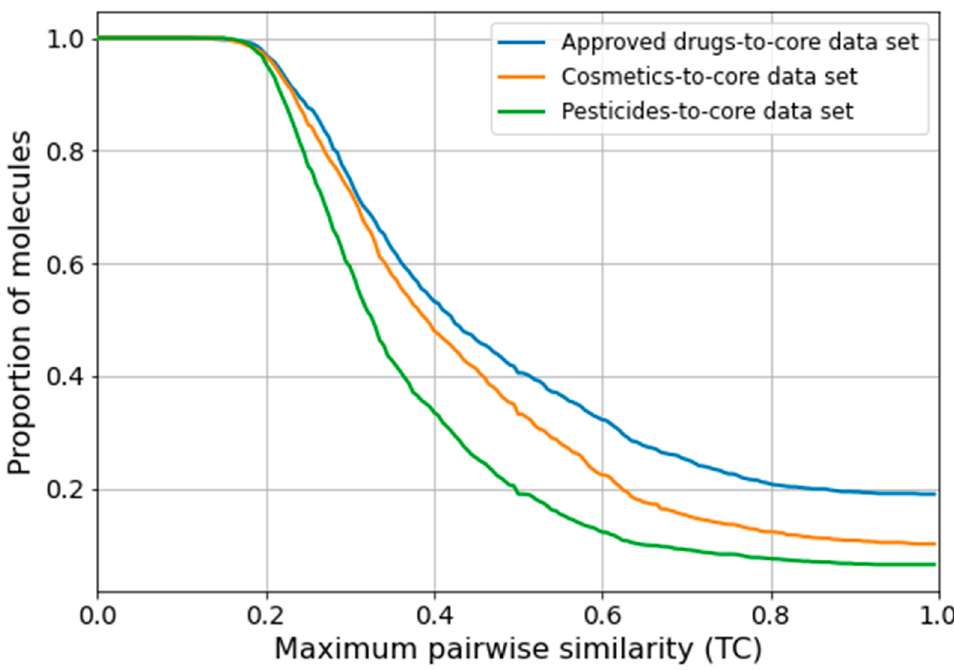
Figure 2. Proportion of molecules in the reference data sets (approved drugs, cosmetic ingredients, and pesticides) with a maximum pairwise molecular similarity above a certain threshold to the core data set. Similarity is expressed as the Tanimoto coefficient based on Morgan fingerprints (2048 bits, radius = 2).